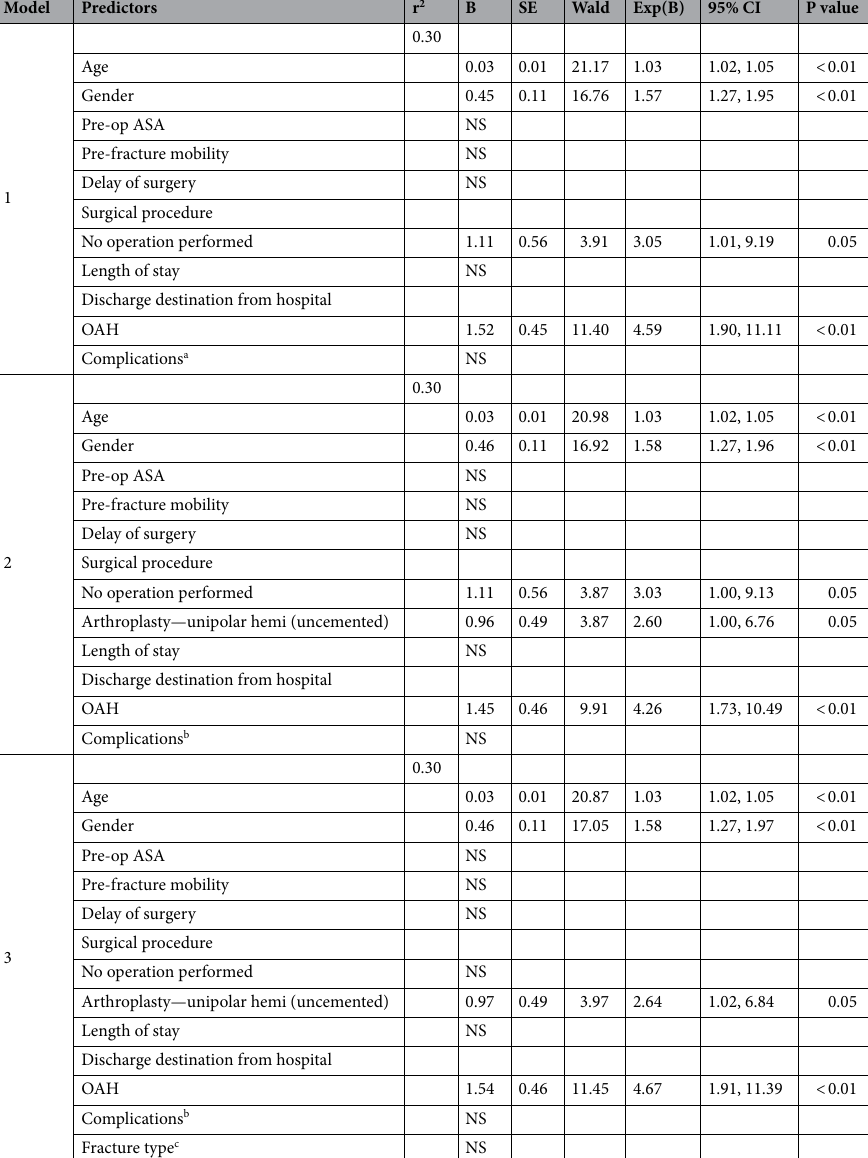
Table 1. Logistic regression models of prognostic factors affecting the deterioration in mobility. Dependent variable: Deterioration in mobility (Ref: No): Key: ASA: American Society of Anesthesiologists, OAH: Old Age Home, NS: Not significant. Predictors: In Model 1: Gender: Male (Ref: Female). Pre-op ASA: Higher risk (Ref: Lower risk). Pre-fracture mobility: Grade 1 Fully ambulatory, Grade 2 Ambulation with 1 aid, Grade 3 Ambulation with frame, Grade 4 Indoor confined, Grade 5 Standing only (Ref: Non-ambulatory). Delay of surgery: Yes (> 48 h) (Ref: No). Operation: Arthroplasty—bipolar hemi (cemented),